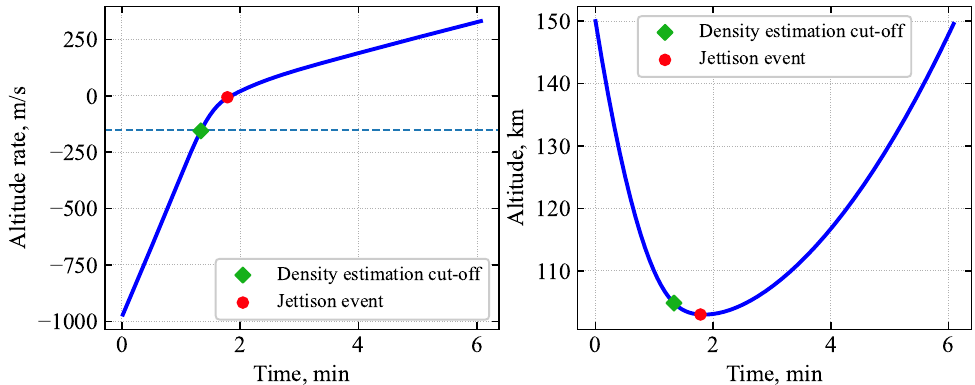
Figure 20. Evolution of altitude rate and altitude during Venus aerocapture. The red circle indicates the time at which drag skirt jettison is